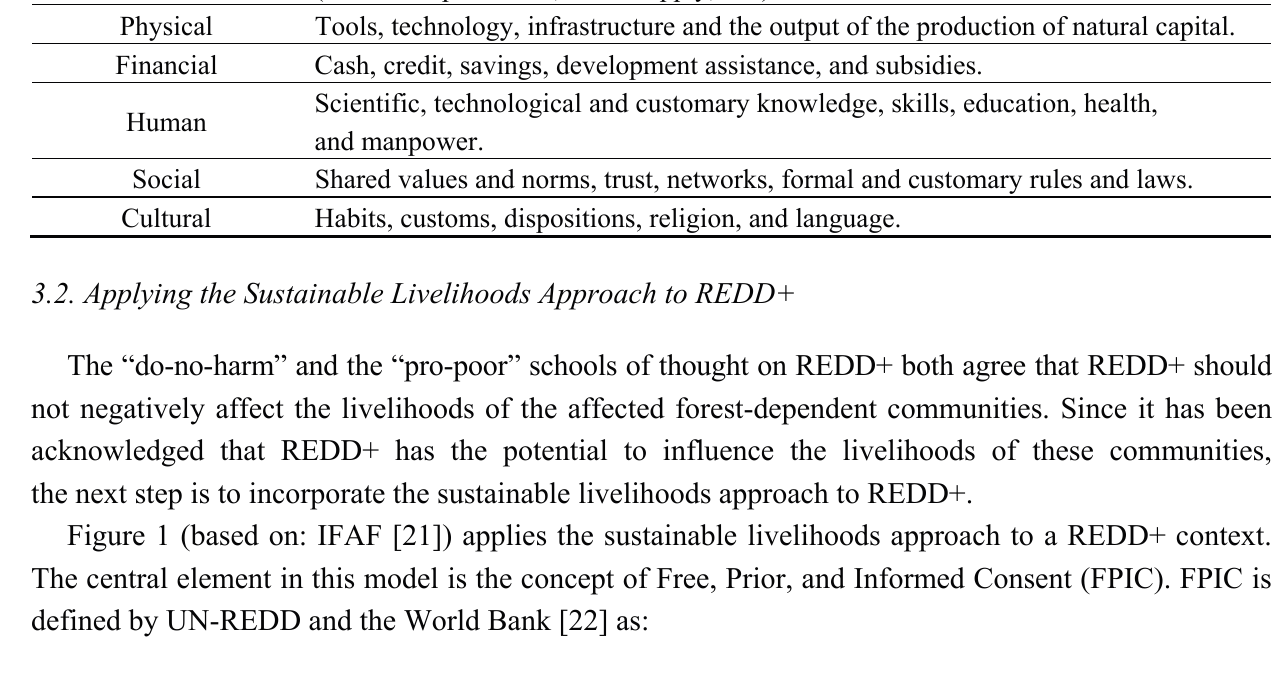
Figure 1 (based on: IFAF [21]) applies the sustainable livelihoods approach to a REDD+ context. The central element in this model is the concept of Free, Prior, and Informed Consent (FPIC). FPIC is defined by UN-REDD and the World Bank [22]